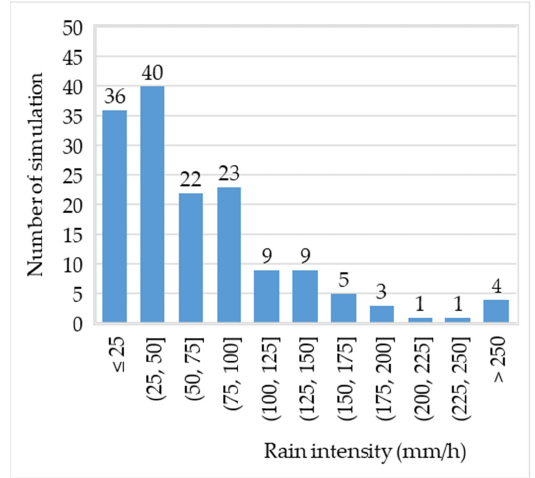
Figure 8. Number of simulations at different intensities of simulated precipitation. Note: simulations with a single dropper or those for which intensity values are given in a range are not included in the analysis.